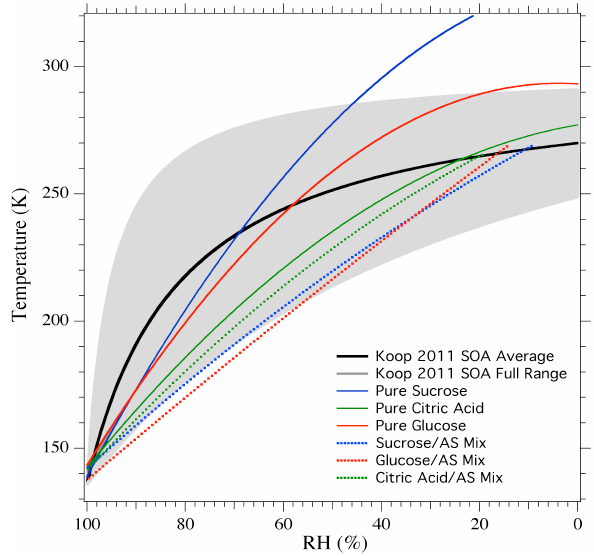
Fig. 5. State diagram depicting experimentally determined T g (RH) curves from this study and the estimated range of T g (RH) for at- mospheric SOA from Koop et al. (2011). This plot indicates that the organics and mixtures investigated in this study may be good proxies for atmospheric